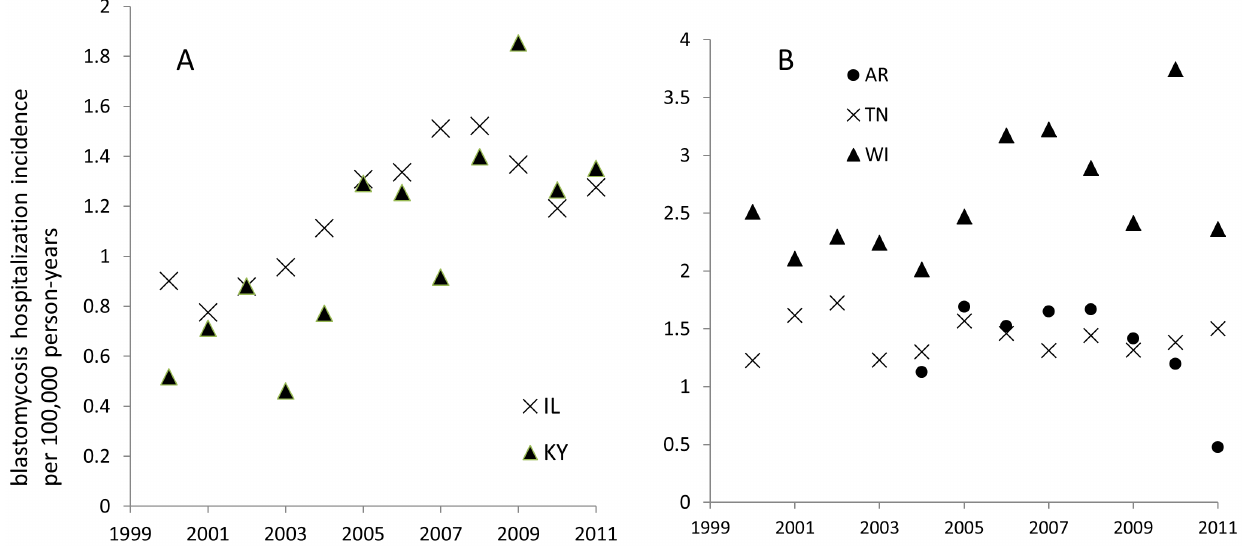
Figure 3. Trends in blastomycosis hospitalization incidence among states with a significant annual percentage change (A) and states with no significant annual percentage change (B).